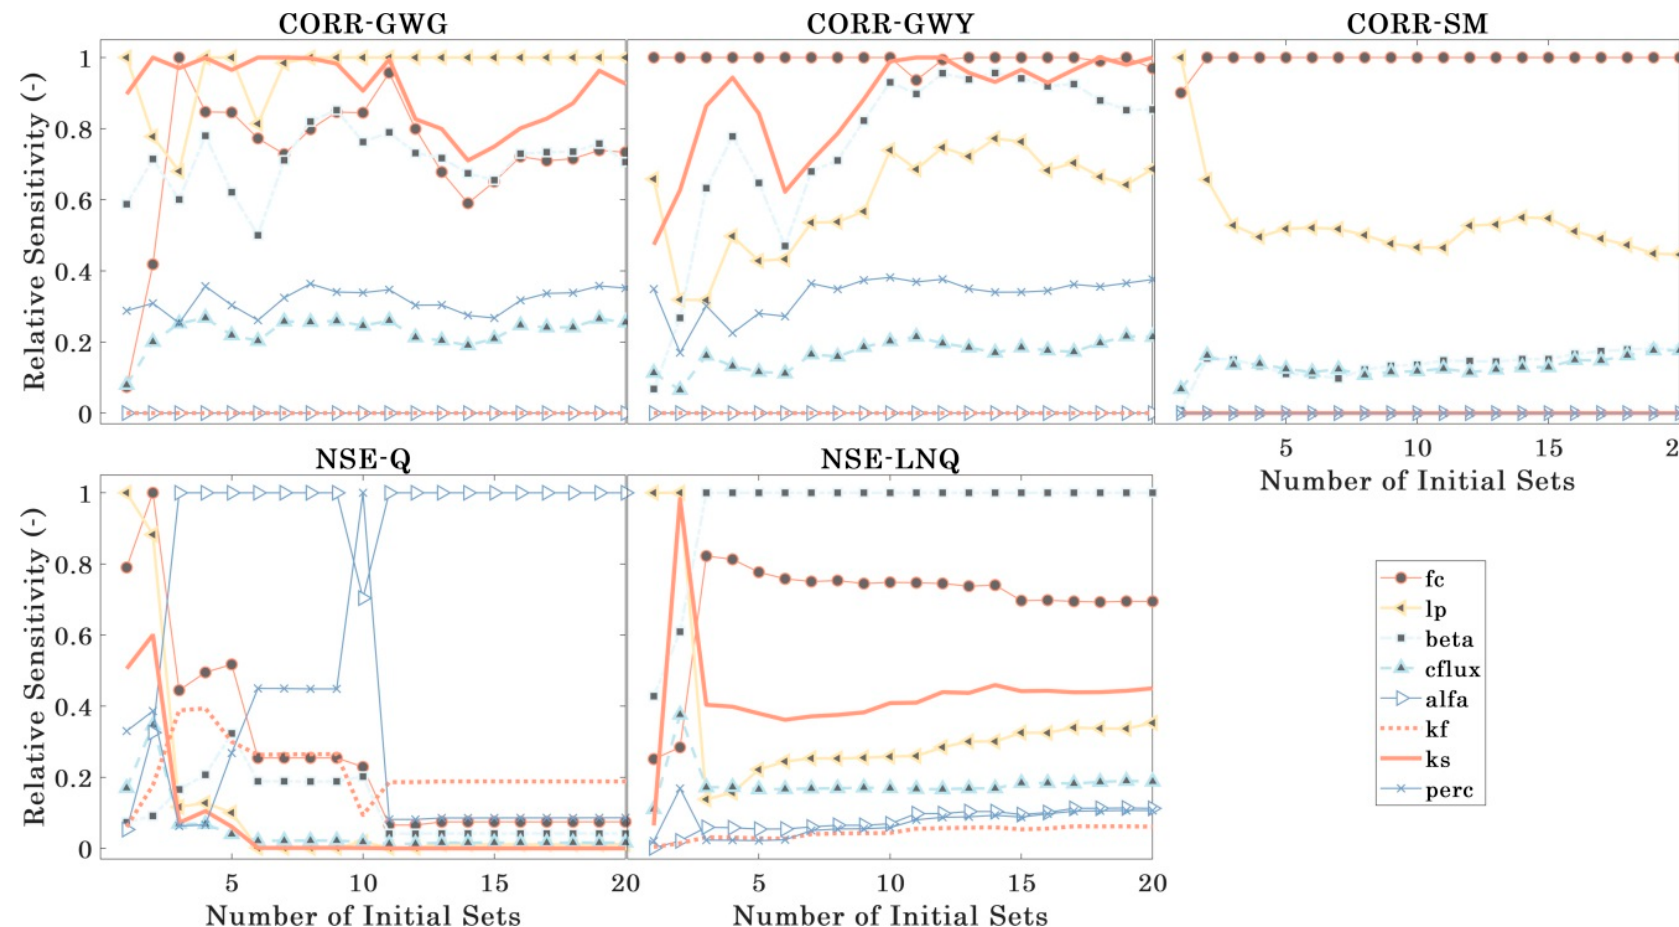
Figure 4. Relative sensitivity of objective functions to HBV model parameters as a function of the number of initial parameter sets.